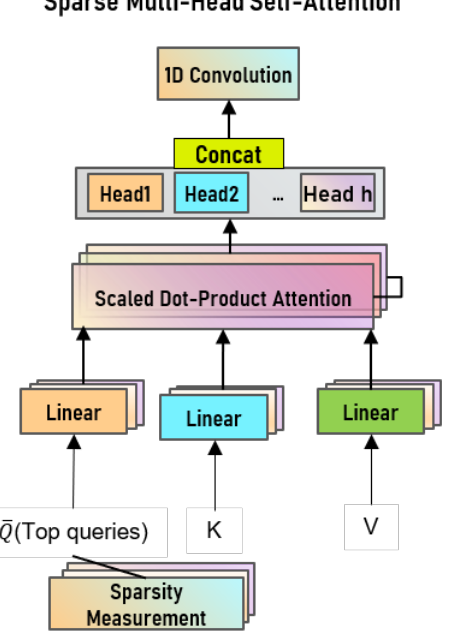
Figure 2. Computational flowchart of multi-head sparse self-attention.